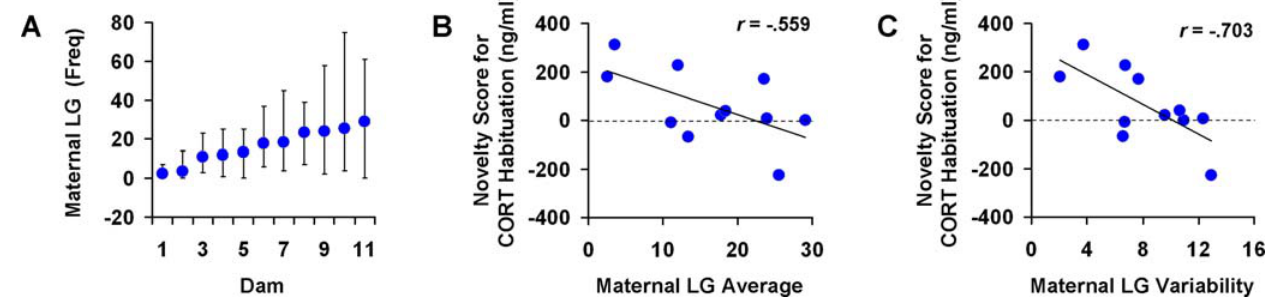
Figure 3. Maternal care during brief 10-min windows immediately after repeated novelty exposure predicts the effect of novelty exposure on CORT habituation among aged offspring. A. Greater average amount of maternal licking and grooming (LG) was associated with greater day-to-day variability in maternal LG (dots and bars indicate average and range, respectively, of LG across days for individual dams; N =11 litters). B. Greater average amount of maternal LG was associated with negative novelty scores for CORT habituation (marginally significant). D. Smaller day-to-day variability in maternal LG was significantly correlated with positive novelty scores for CORT habituation.